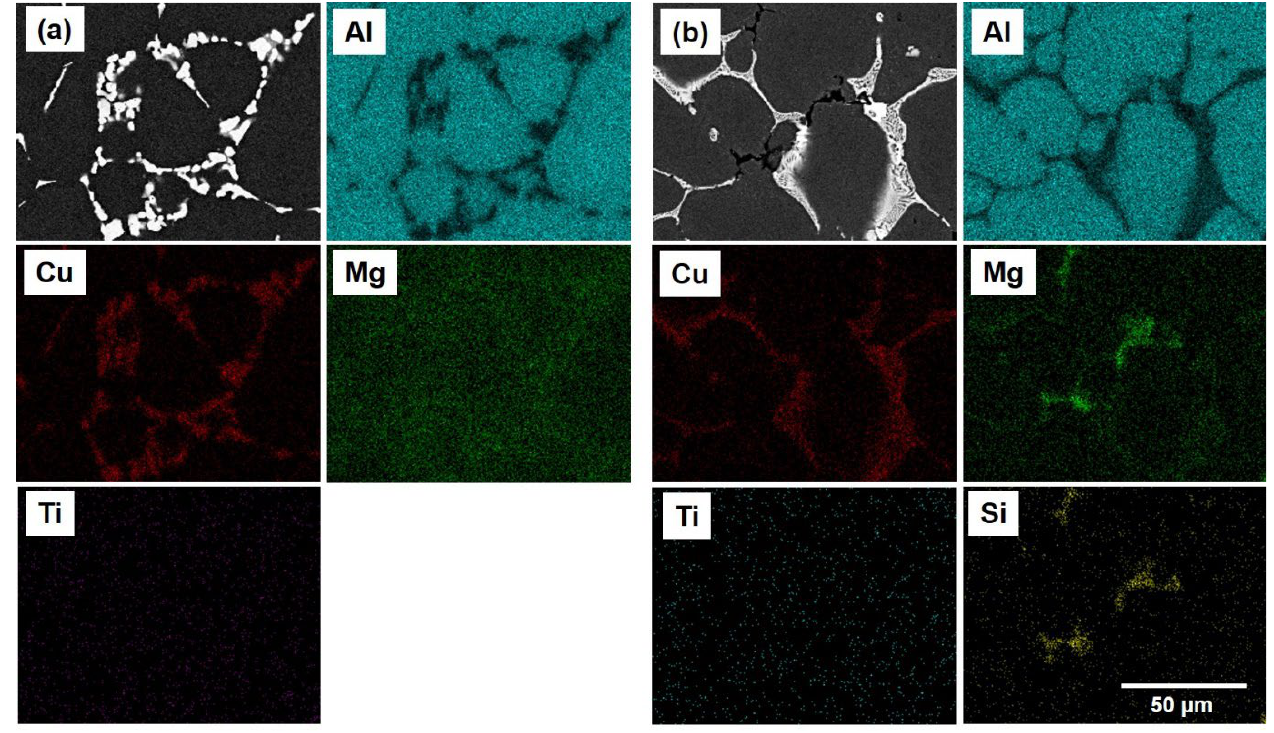
Figure 5. FE - SEM micrographs of ( a ) the B43 alloy and ( b ) the S43 alloy, along with their corresponding EDS mapping analyses.